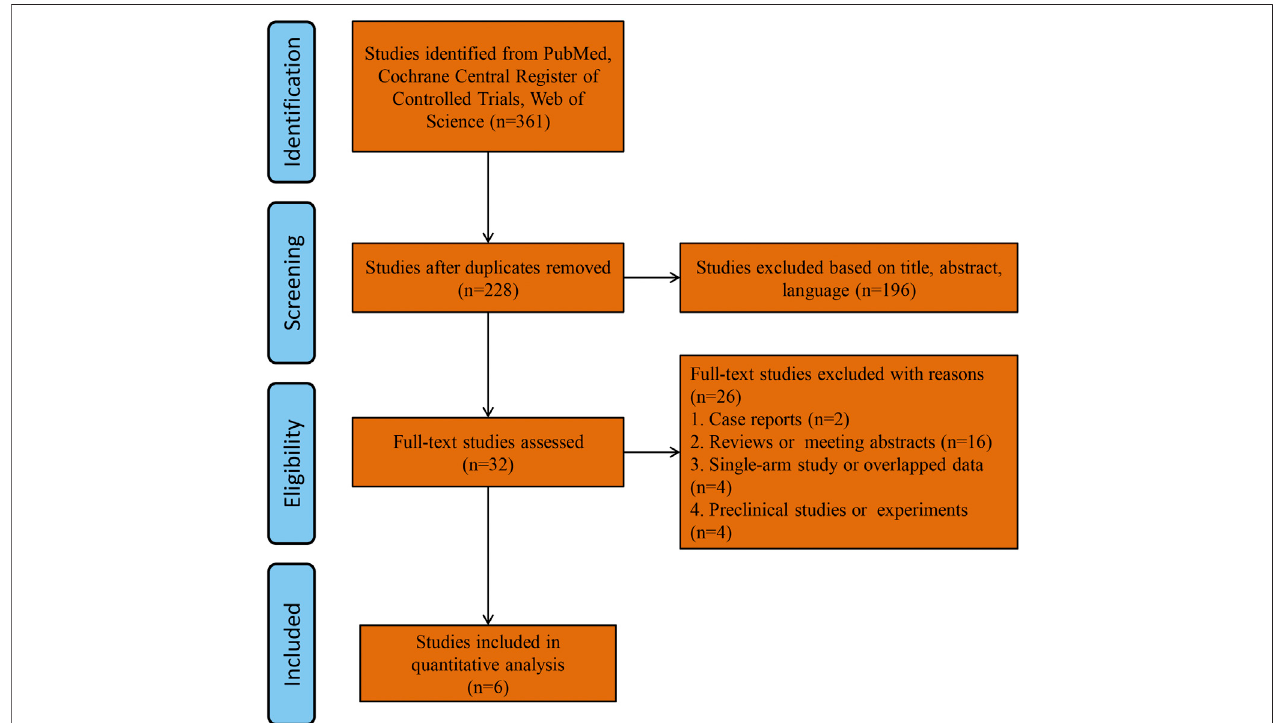
FIGURE 1 | Flow chart of this